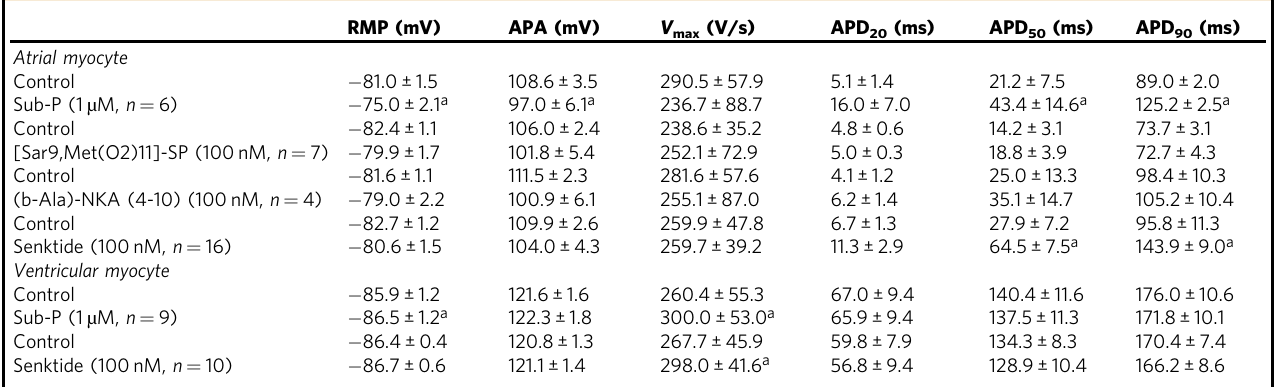
Table 1 Effects of substance-P and selective NK-1, NK-2 and NK-3 receptor agonists on action potential parameters in atrial and ventricular myocytes